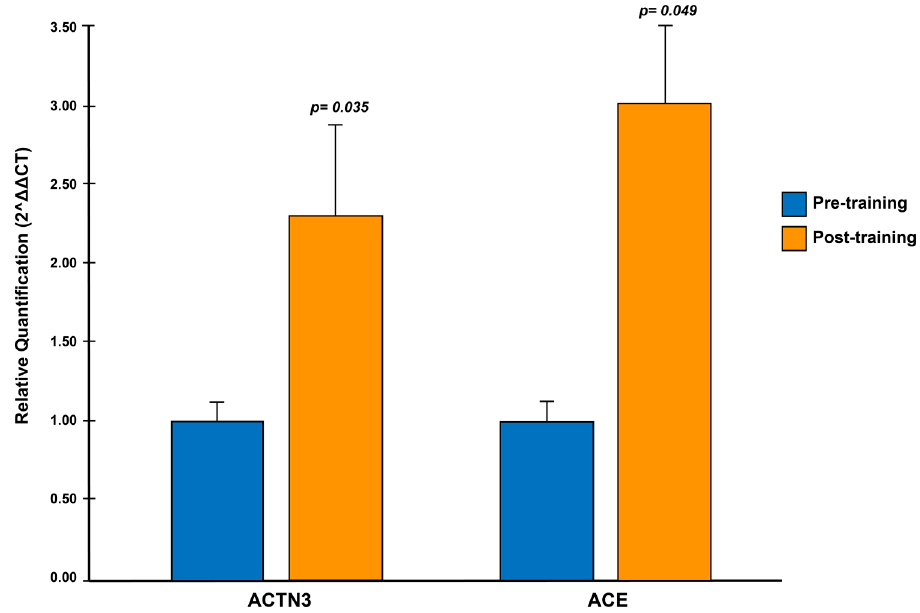
Figure 3. Relative quantification of the expression of the ACTN3 and ACE genes using the method 2 − ∆∆ Ct .